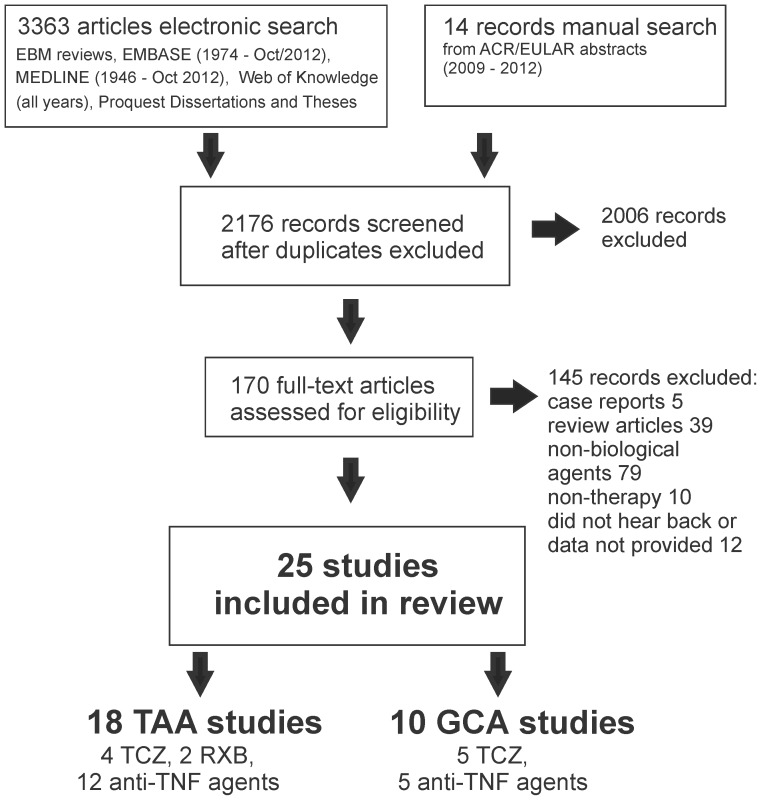
Schematic overview of the studies included in this review.25 studies were included in this review. Of those, three studies included both GCA and TAA patients. One case series with TAA patients was not included in the analysis as its patients were included in a subsequent follow-up study [24], [42].